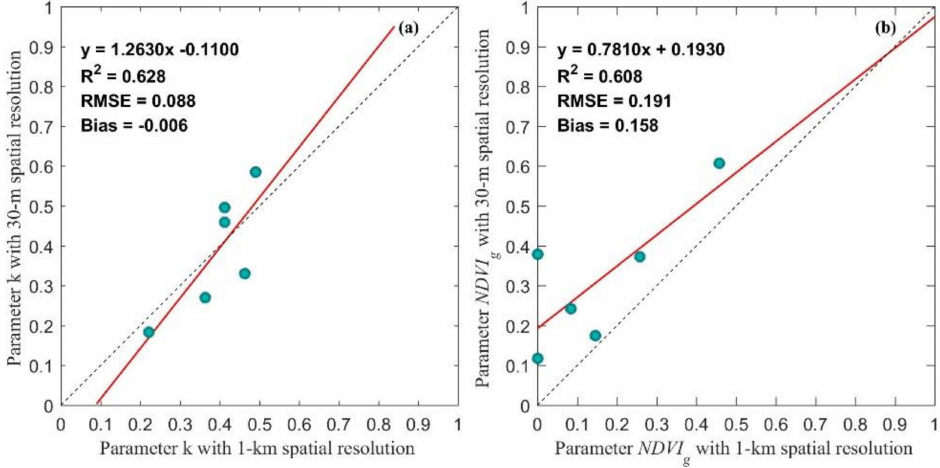
Figure 15. The scaling equations of model parameters at the cropland sites. ( a ) k ; ( b ) NDVI g